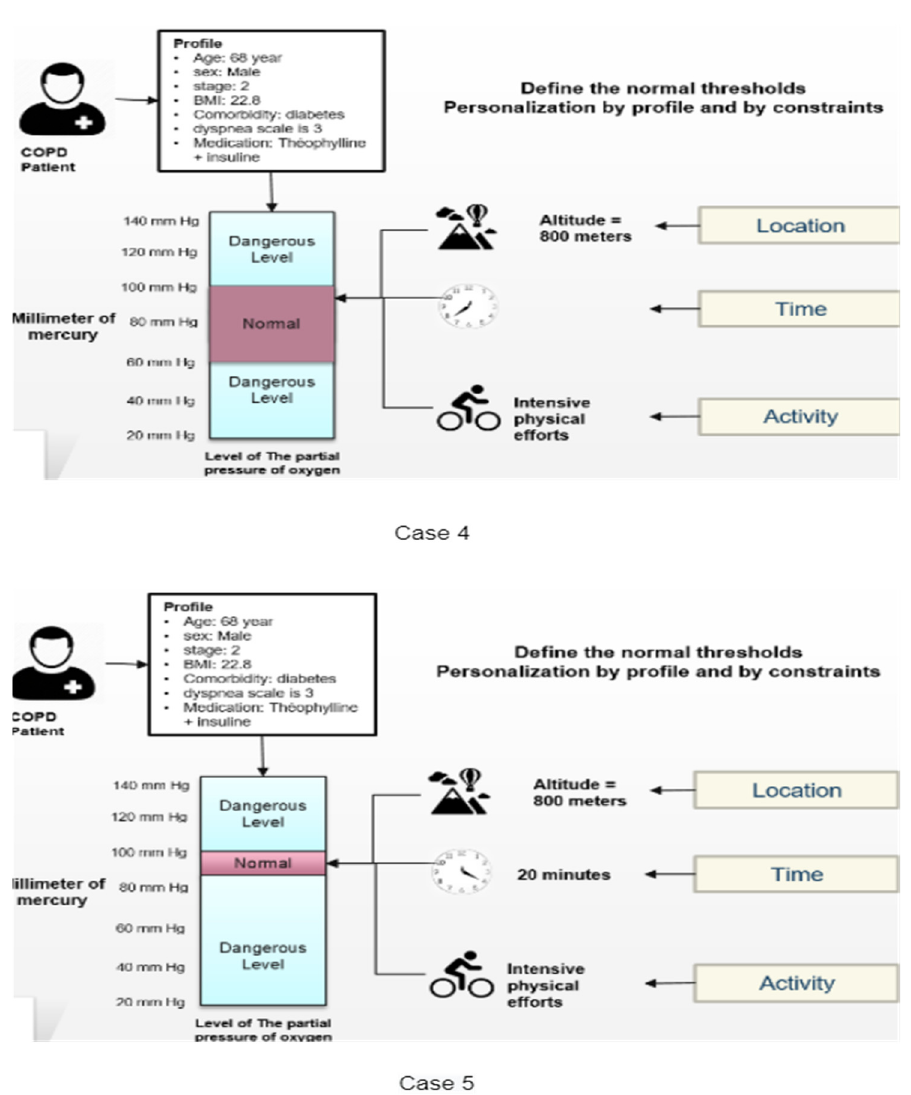
Figure 7. Testing and adaptation scenario.